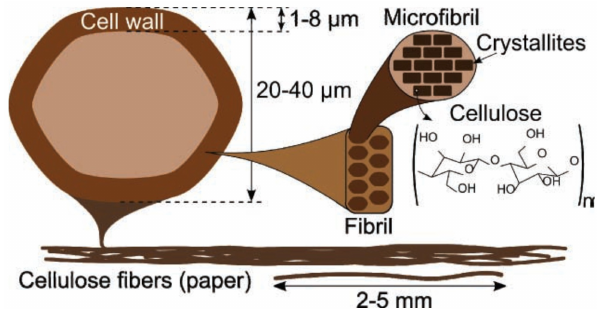
Figure 6. Cross section of cellulose fibers along with cell wall constructional details. Reprinted with permission from [65] c (cid:13) 2011 Wiley online